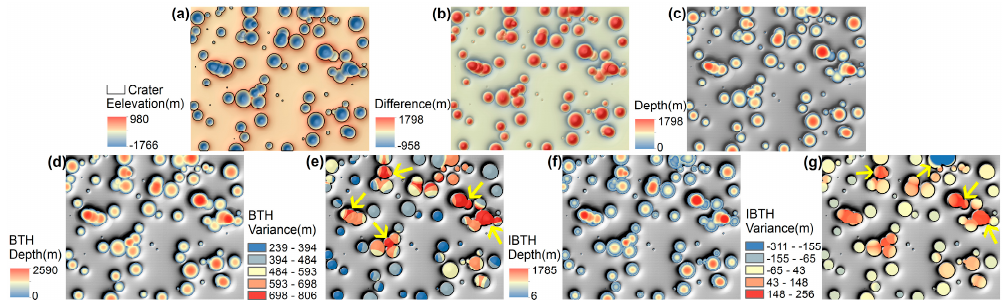
Figure 4. Simulated test surface and depth estimates. ( a ) Simulated cratered surface; ( b ) difference between initial and cratered surfaces; ( c ) difference surface thresholded at 0 m to extract crater depth; ( d ) crater depth extracted by BTH; ( e ) difference between ( d ) and ( c ), the arrows point out that the more red the color, the greater the difference, and the less accurate the estimation; ( f ) crater depth extracted by IBTH; ( g ) difference between ( f ) and ( c ), the arrows pointed that the darker the color, the greater the difference, and the less accurate the estimation.